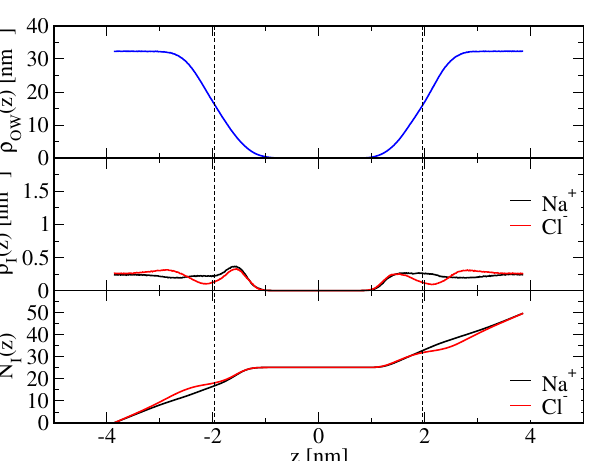
Figure 2. As Figure 1, but for simulation S NaCl (m1,wc), i.e., a simulation based on a modified force field (Table 7). The corresponding apparent binding constants are reported in Table 2.